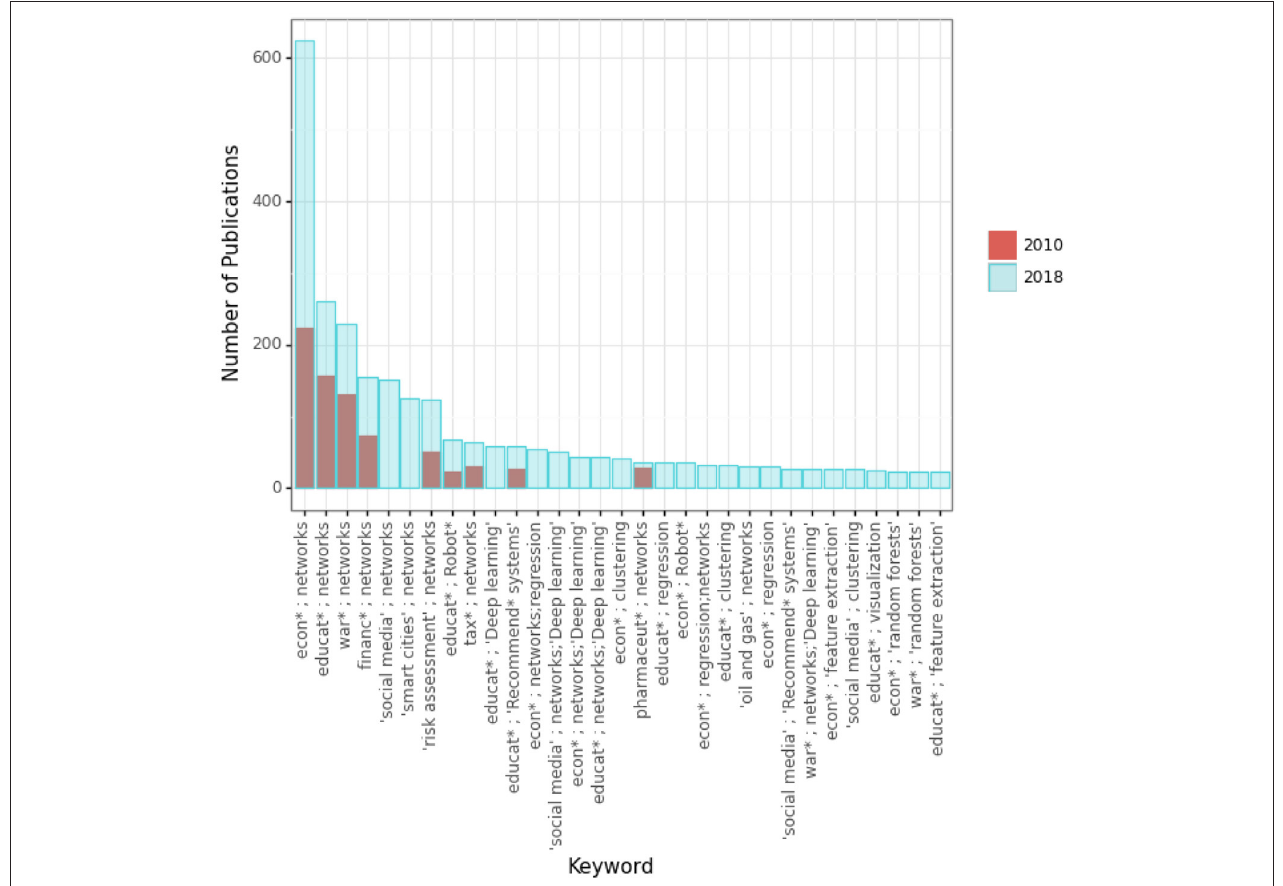
FIGURE 8 | Number of publications with at least one pair of “social”; “technical” keywords in 2010 and